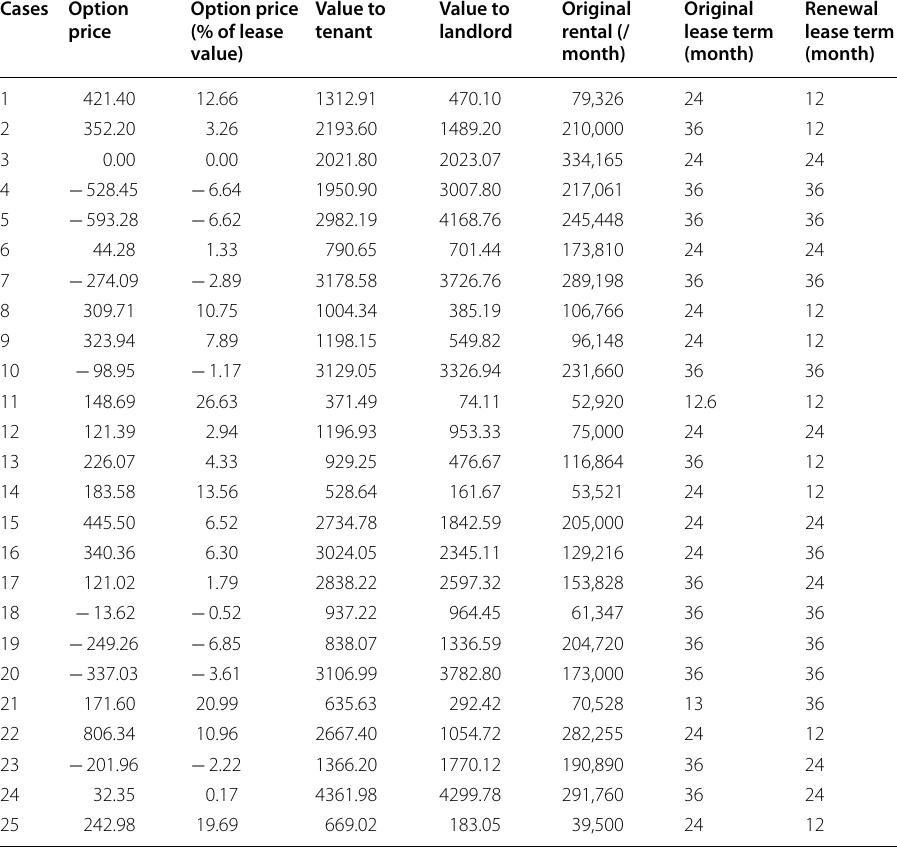
Table 5 Option price and option value for both parties (HK$ thousand) Cases Option